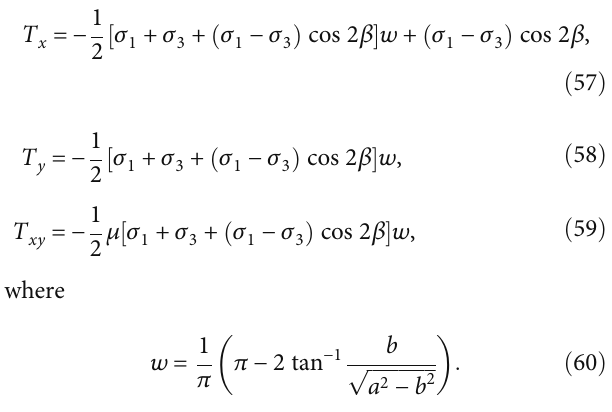
Figure 13: The typical isochromatic pattern around the nonclosed inclined crack in the plate